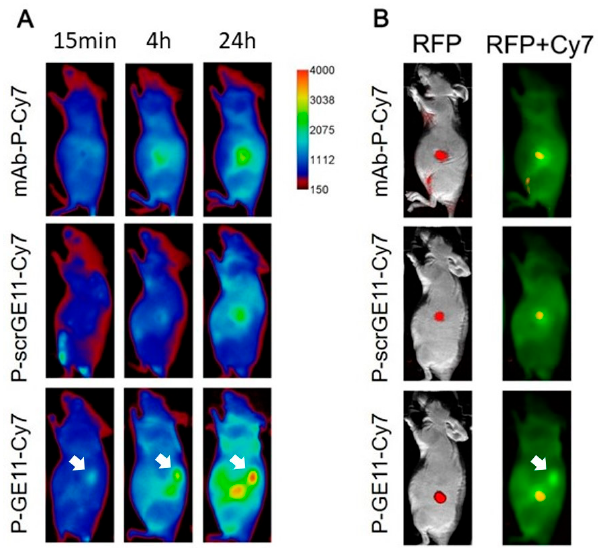
Figure 7. Tumor targeting of polymer probes containing Erbitux, GE-11scr and GE-11 ( mAb-P-Cy7 , P-scrGE11-Cy7 , P-GE11-Cy7 ). White arrow shows kidney. ( A ) Cy-7 fluorescence signal in representative mice at three di ff erent times; ( B ) RFP signal from RFP-expressing tumor cells in red and Cy-7 fluorescence signal in green, showing the colocalization of signals. Number of mice n = 8. The conjugate with EGF (P-EGF-Cy7) exhibited no significant accumulation in the tumor over time. At all intervals, the strength of the signal was similar to that of the control polymer (sP-Cy7) (Figure 6). In the case of P-EGF-Cy7, analysis of the Cy-7 signal beyond the tumor area revealed